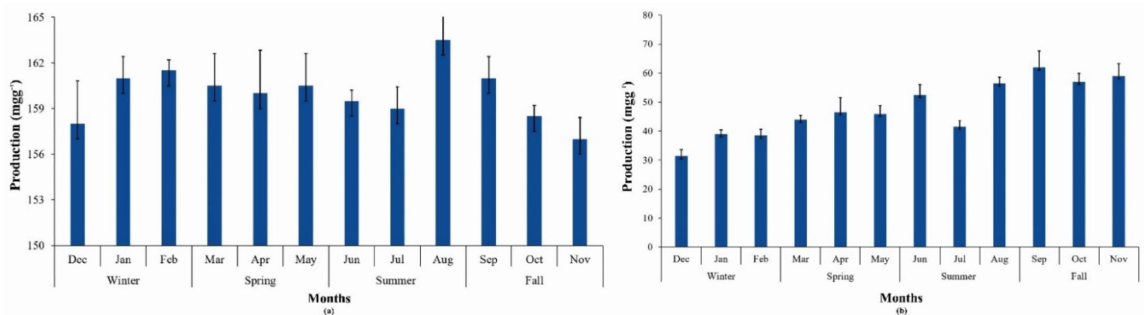
Figure 4. Phycobilin yield during different seasons and their variations throughout the year in ( a ) MBG11; ( b )